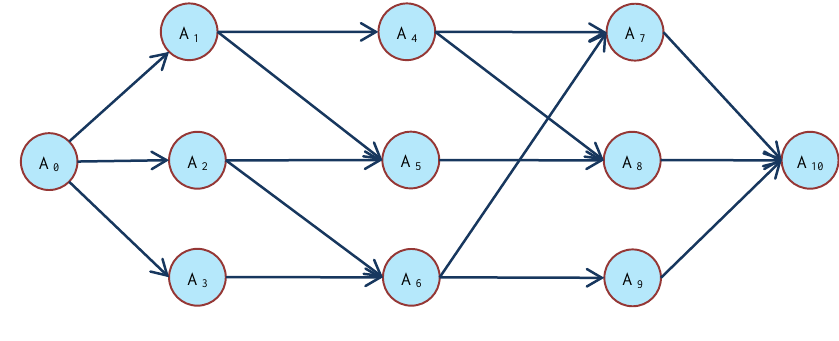
Fig. 1. A project with nine